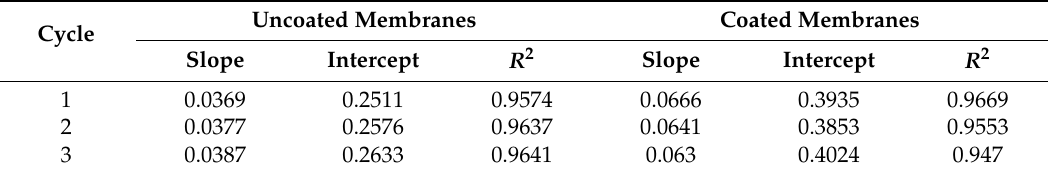
Table 2. Slope, intercept and R 2 values on fitting the Complete Pore Plugging model fitted for flux data. Uncoated Membranes Coated Membranes Cycle Slope Intercept R 2 Slope Intercept R